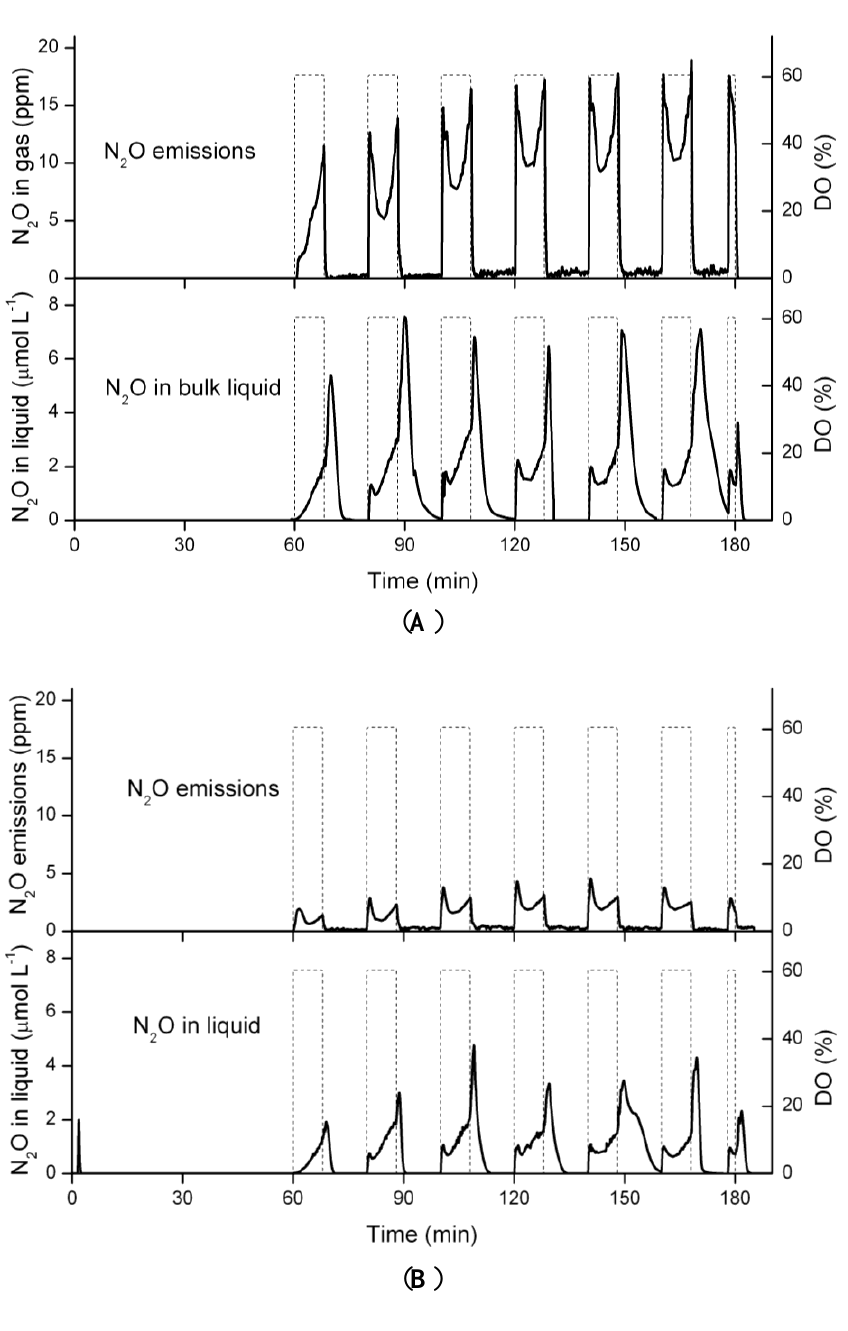
Figure 8. Typical profiles of nitrous oxide concentrations in the effluent gas and the bulk liquid during a SBR cycle. The dashed lines show schematically the aeration strategy: ( A ) N-removal over nitrite with intermittent aeration, ( B ) N-removal over nitrate with intermittent aeration, ( C ) N-removal over nitrite with constant DO of 30% and ( D ) N-removal over nitrate with constant DO of 30%. The shown profiles have been measured with 400 mgCOD·L −1 influent